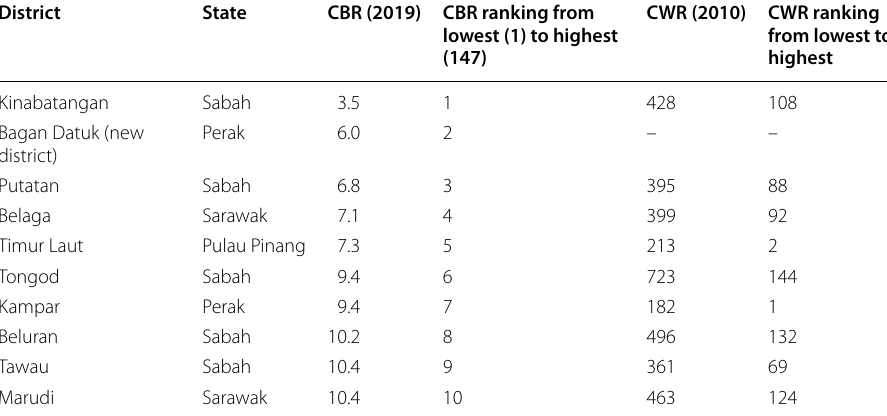
Table 4 Top 10 districts in Malaysia with the lowest CBR, 2019